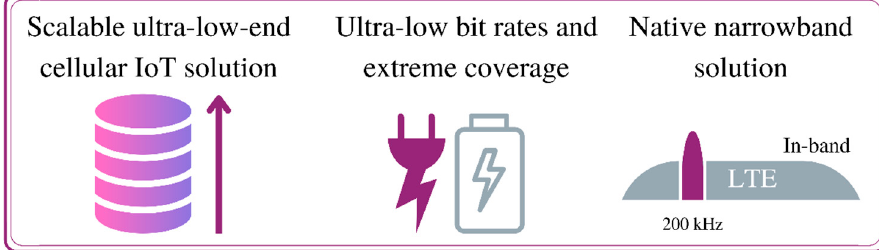
Figure 4. NB-IoT’s main features.